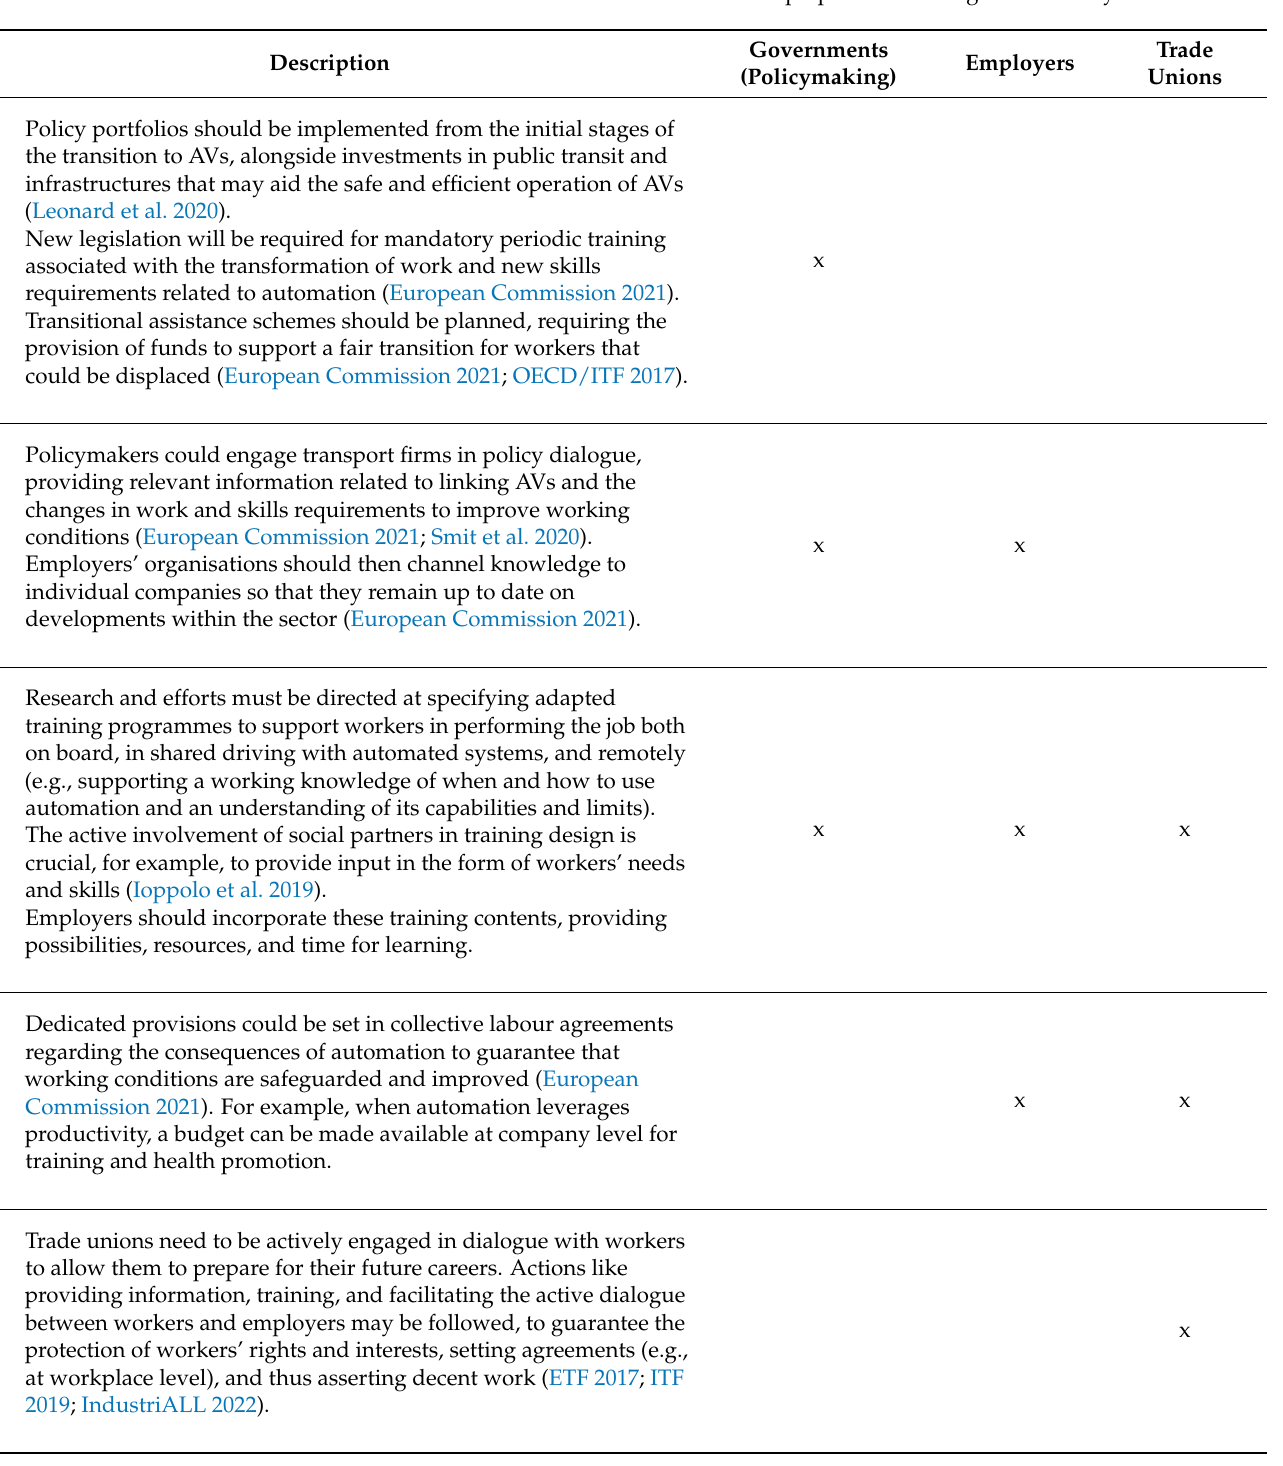
Table 2. Initiatives and actions that can be used to prepare and manage the mobility of the